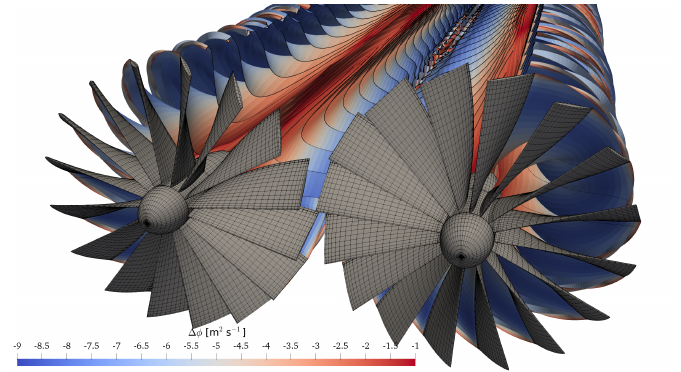
Figure 4. Twin-propeller computational mesh for the case dist = 0.